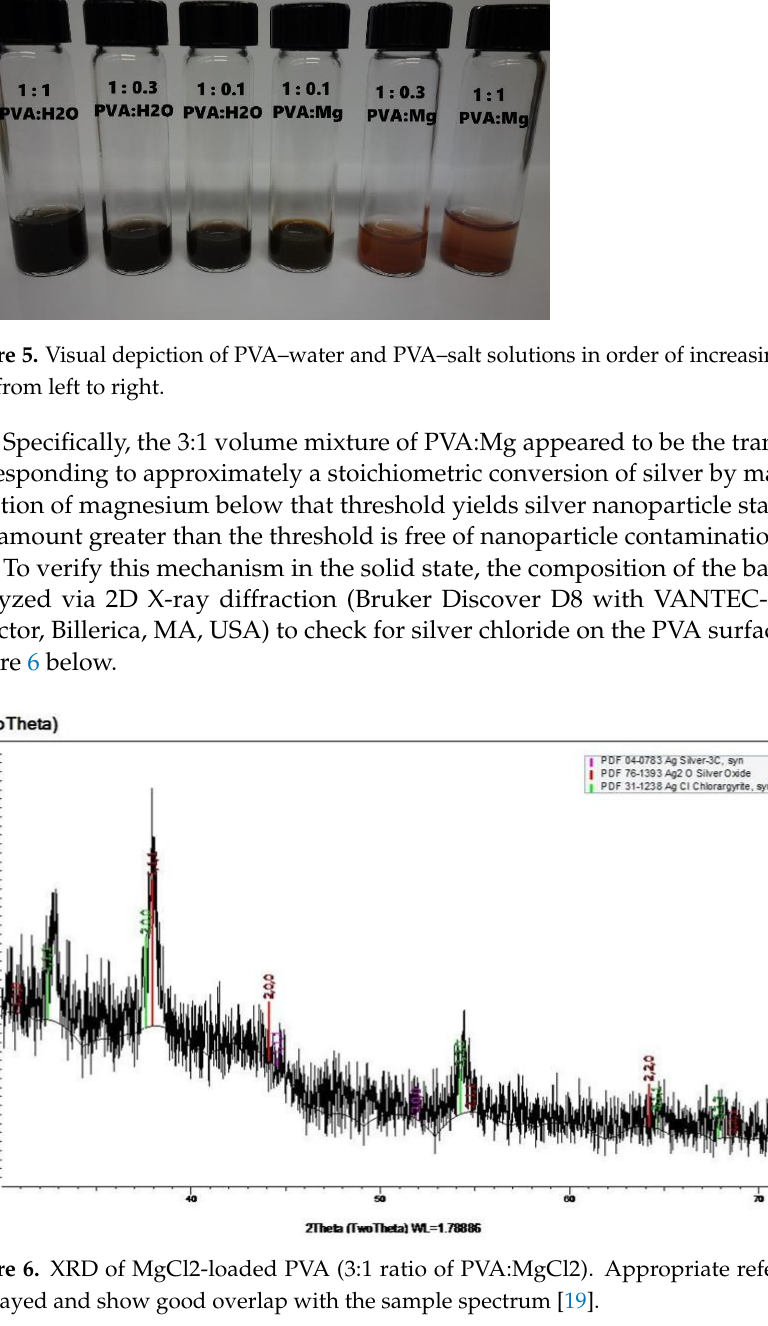
Figure 4. Proposed mechanism of loaded salt as a barrier to silver staining on PVA films.